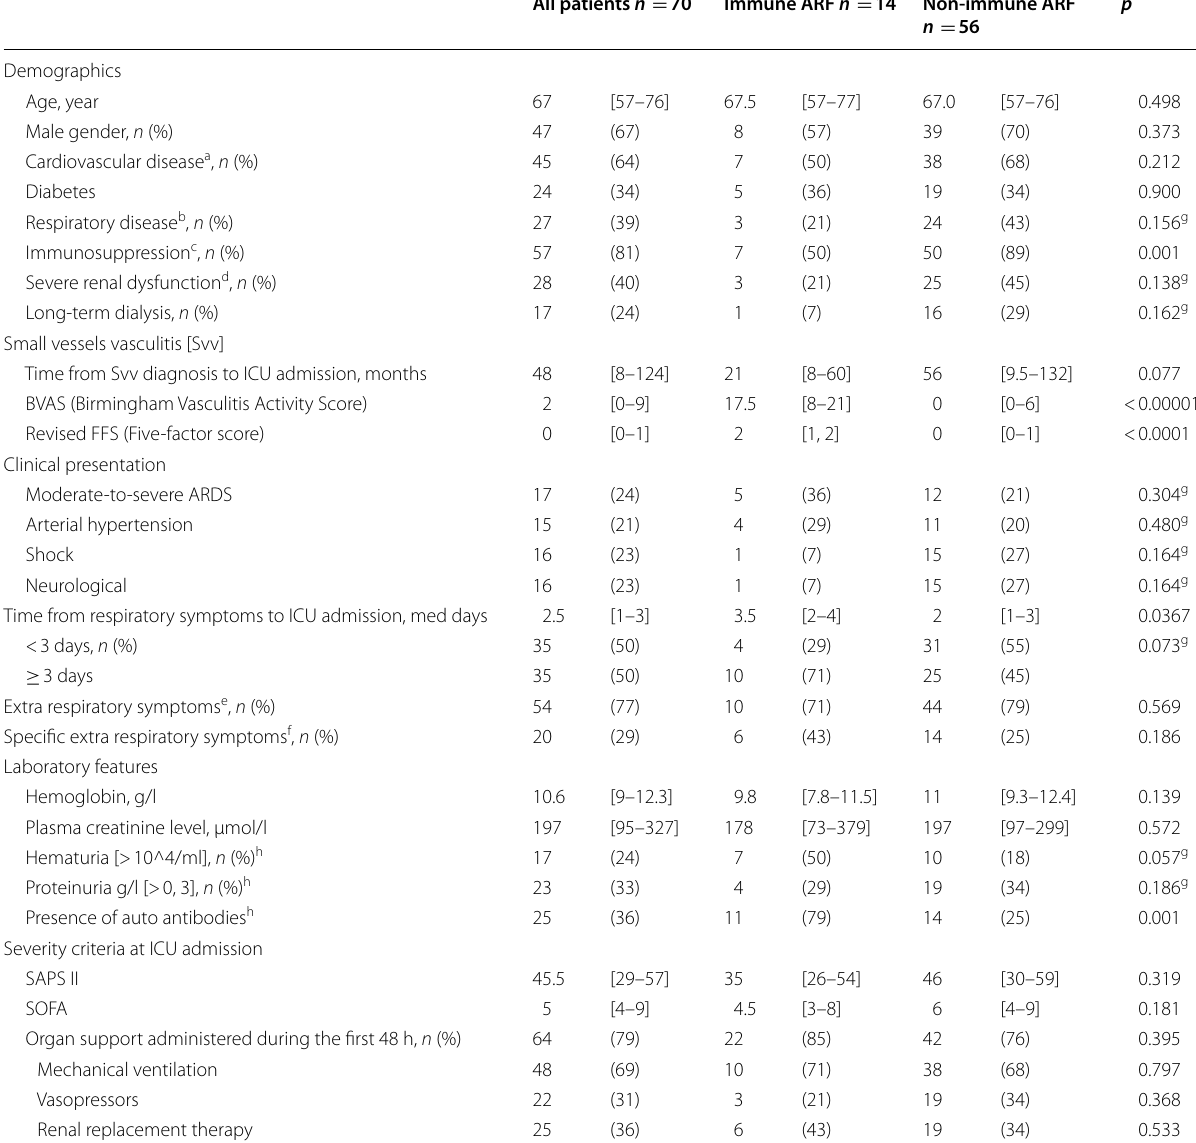
Table 4 Characteristics of ARF complicating a known Svv on ICU admission (n